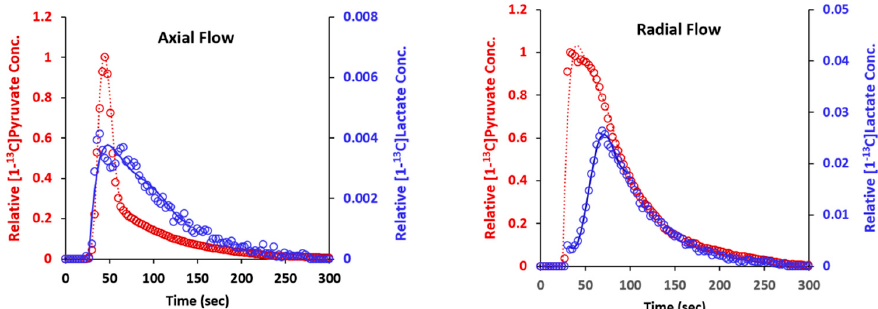
Figure 8. Kinetic profiles of [1- 13 C] pyruvate (red trace) and [1- 13 C] lactate (blue trace) for cells with axial ( left ) and radial ( right ) perfusion in DMEM-I. The smoothed curves are least-square-fit sixth-order polynomials that were used to determine the time-to-peak.